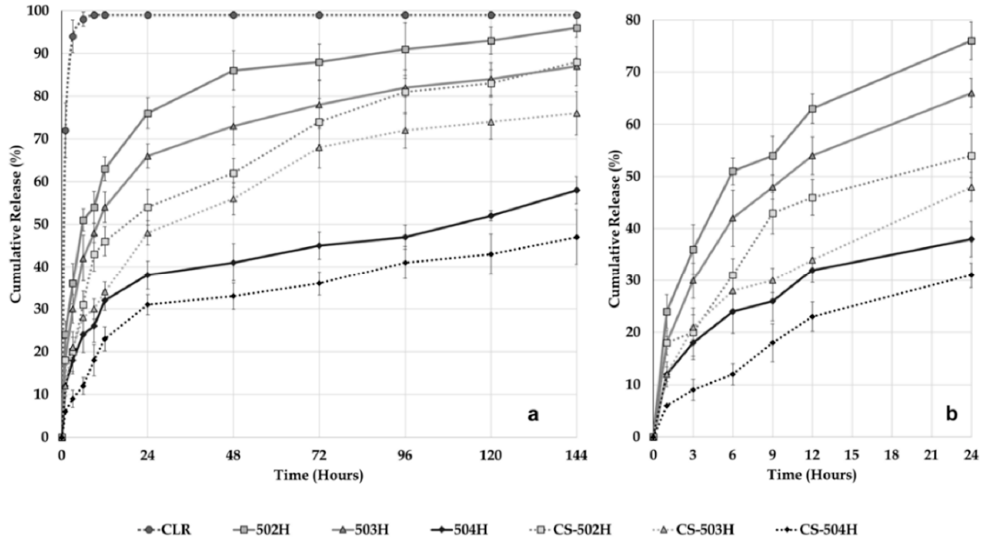
Figure 4. In vitro release of pure CLR, CLR from PLGA NPs and CS-coated PLGA NPs at 37 °C in intestinal fluid phosphate buffer pH 6.8 supplemented with 1% Tween 80. ( a ) 144 hours release profile, ( b ) 24 hours release profile.